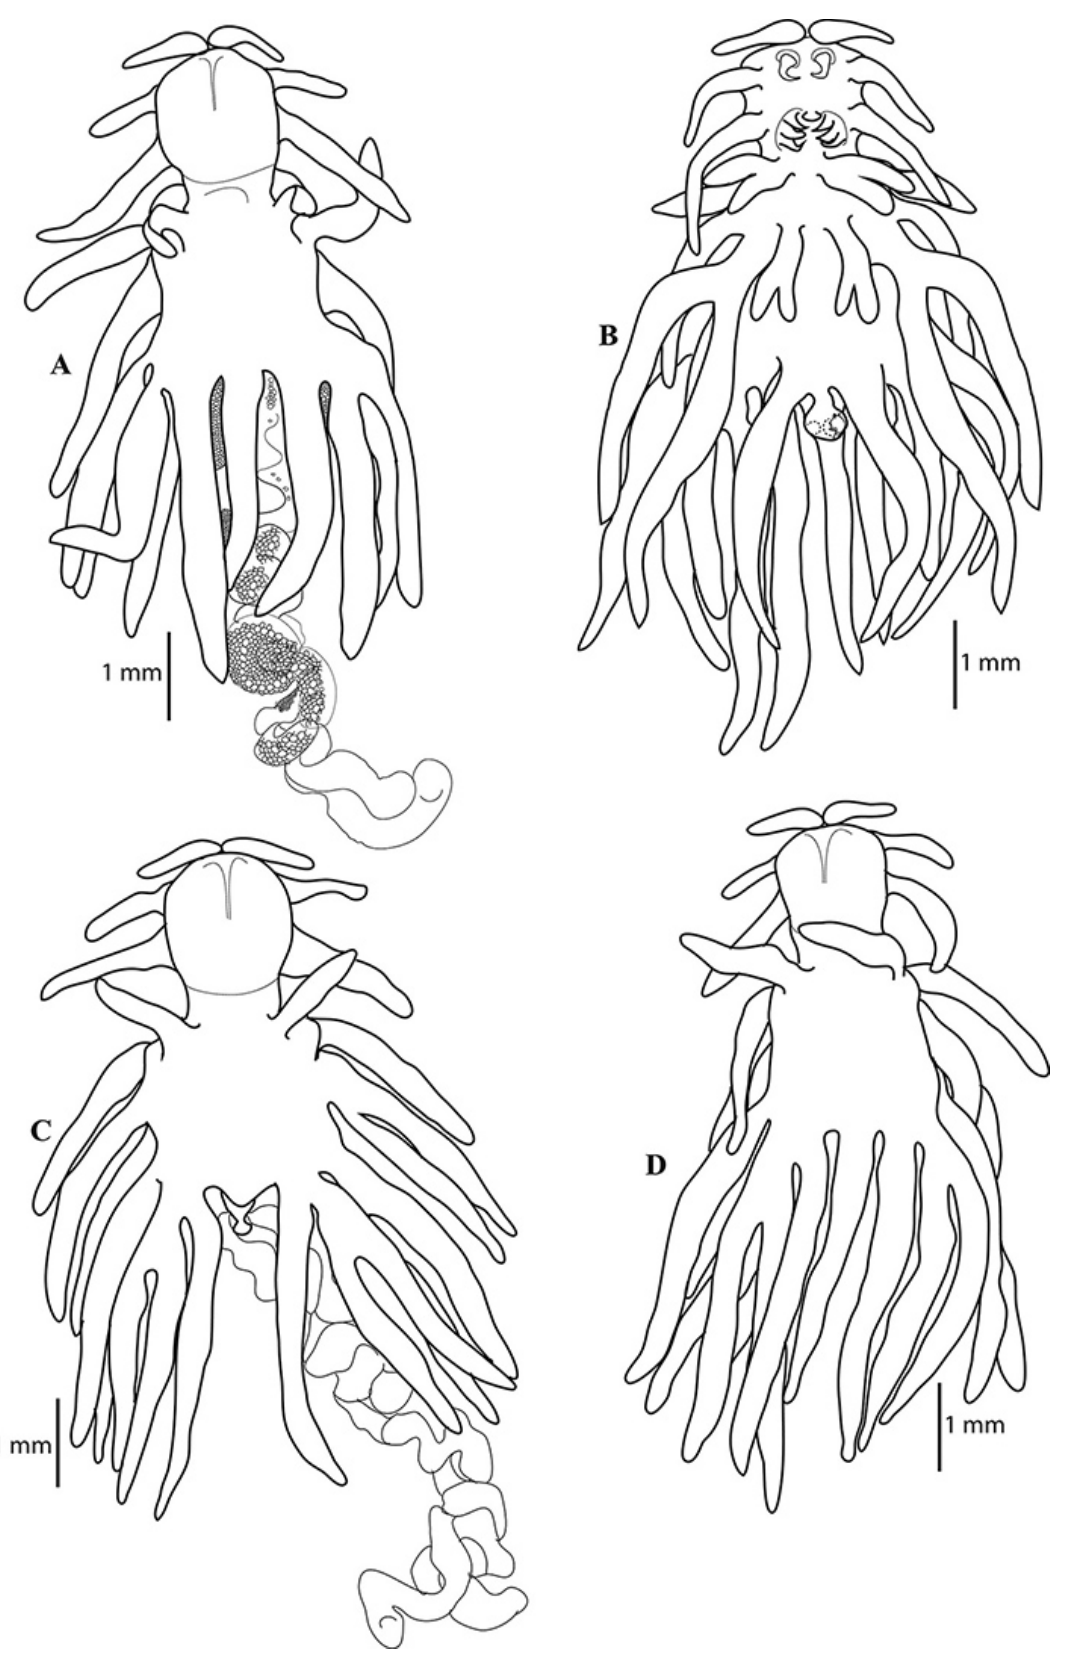
Figure 9. Chondracanthus kabatai sp. n. from Zenopsis conchifer Lowe. A , B . Holotype, female, dorsal and ventral view. C . Paratype, female (ZSI/WGRC/IR/INV/11732), dorsal view, D . Paratype, female (ZSI/WGRC/IR/INV/11729), dorso-lateral